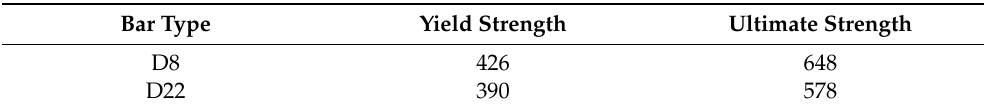
Table 1. Strengths of steel